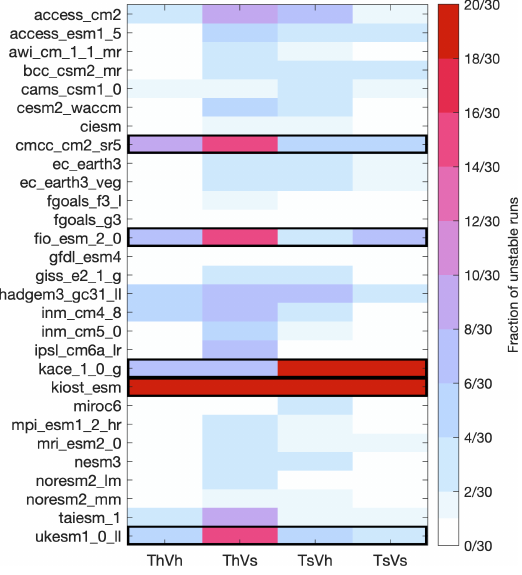
Figure A2. For each model mean state combination, the fraction of the 30 ensemble members that met the instability criterion described in Sect. 2. Models omitted from our analysis (those for which 10 or more of their ensemble members for any of the mean state combinations became unstable) are indicated by the black outline. Th (Ts) indicates the mean state dry static stability from the historical (future) period; Vh (Vs) indicates the mean state winds from the historical (future)